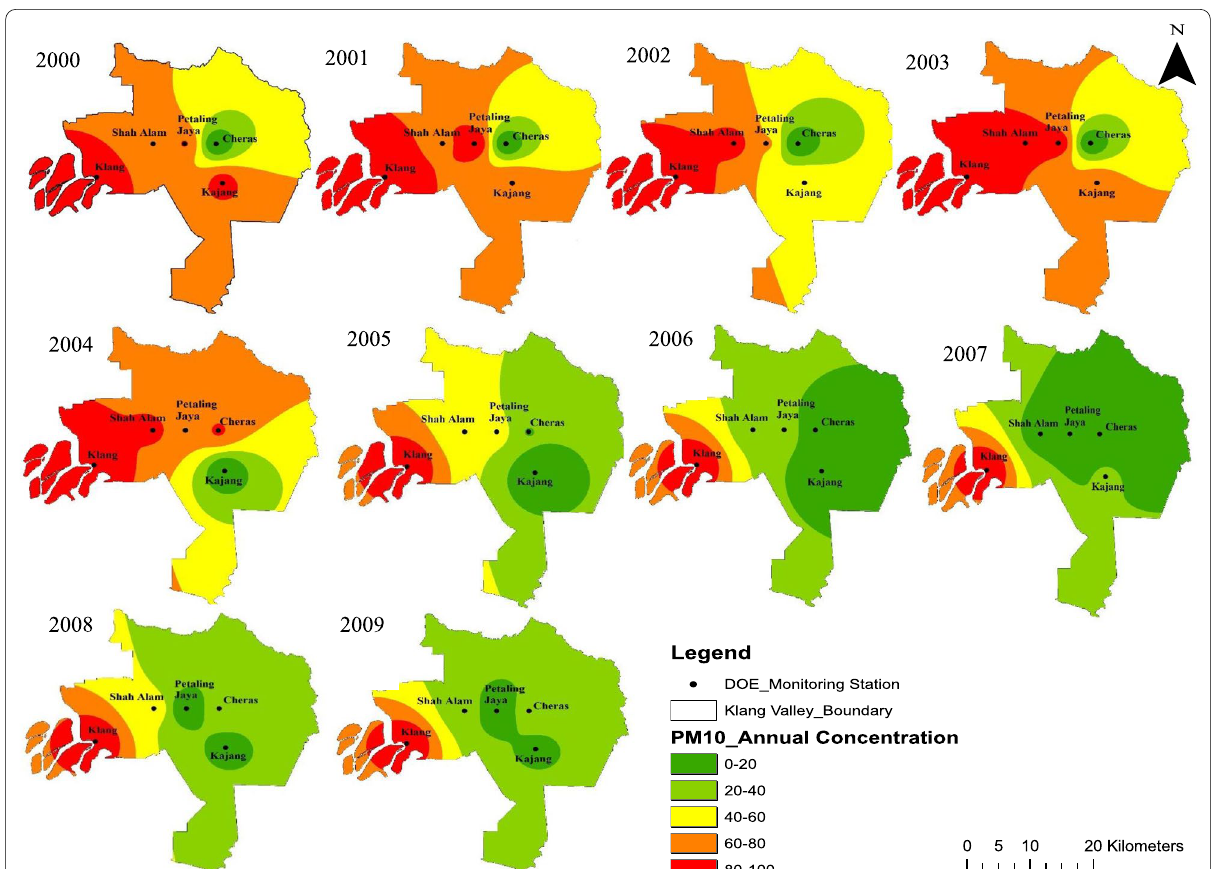
concentrations in the Klang 10